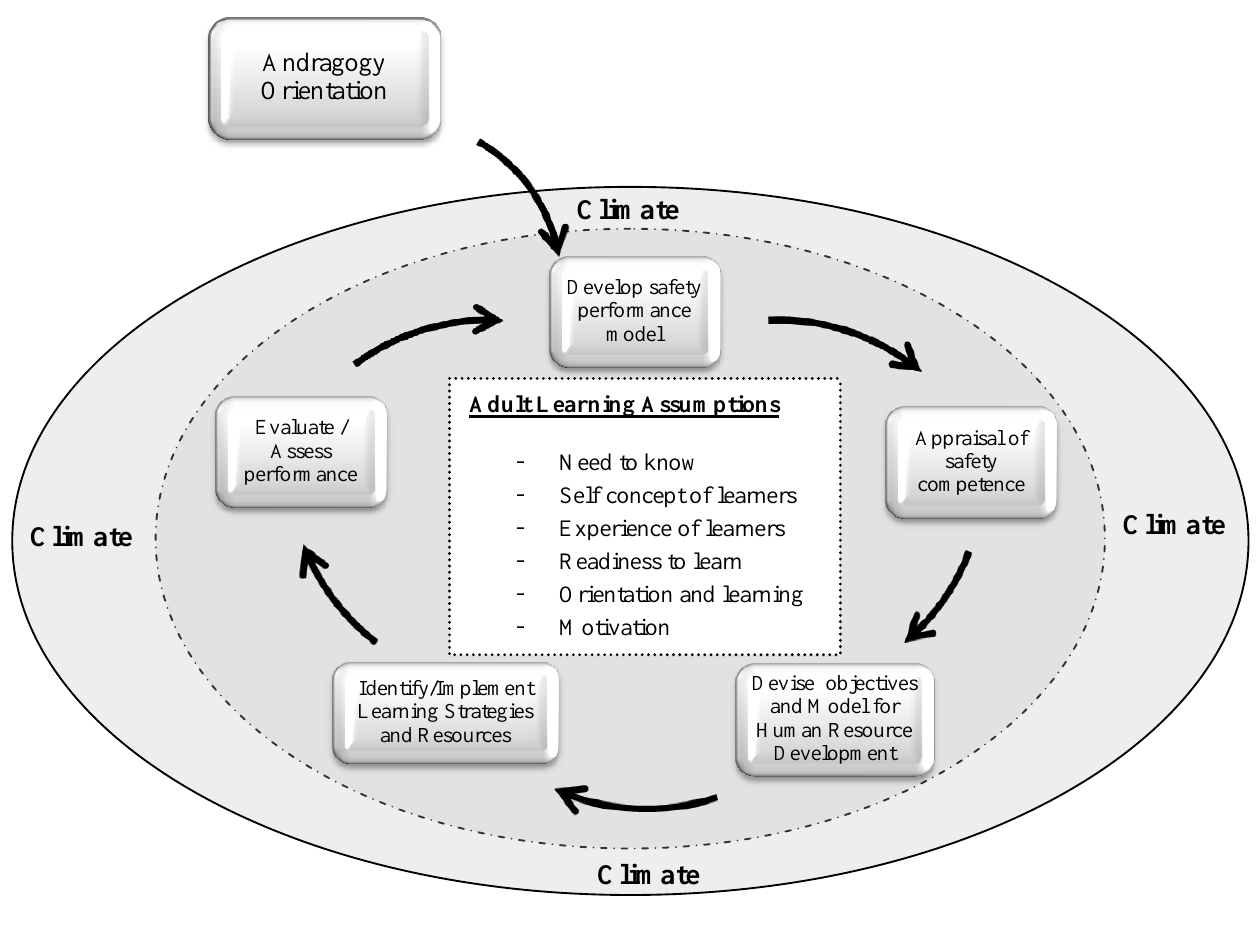
Figure 3 Andragogy based safety training